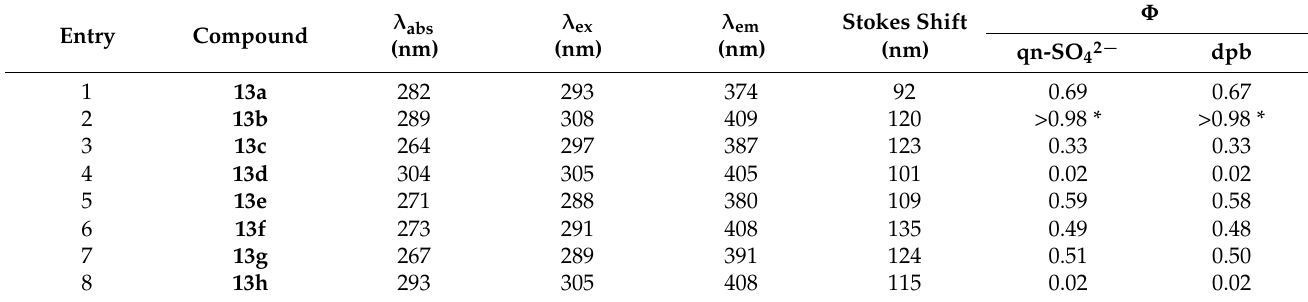
Table 4. Spectroscopic data for the studied s-tetrazine derivatives. λ abs —wavelength of absorption maximum directly preceding λ em . λ ex and λ em —excitation and emission wavelength at global fluorescence maximum. Stokes shift was calculated as λ em − λ abs . The quantum yields Φ were determined according to the method described by Brouwer [31] by comparison with two